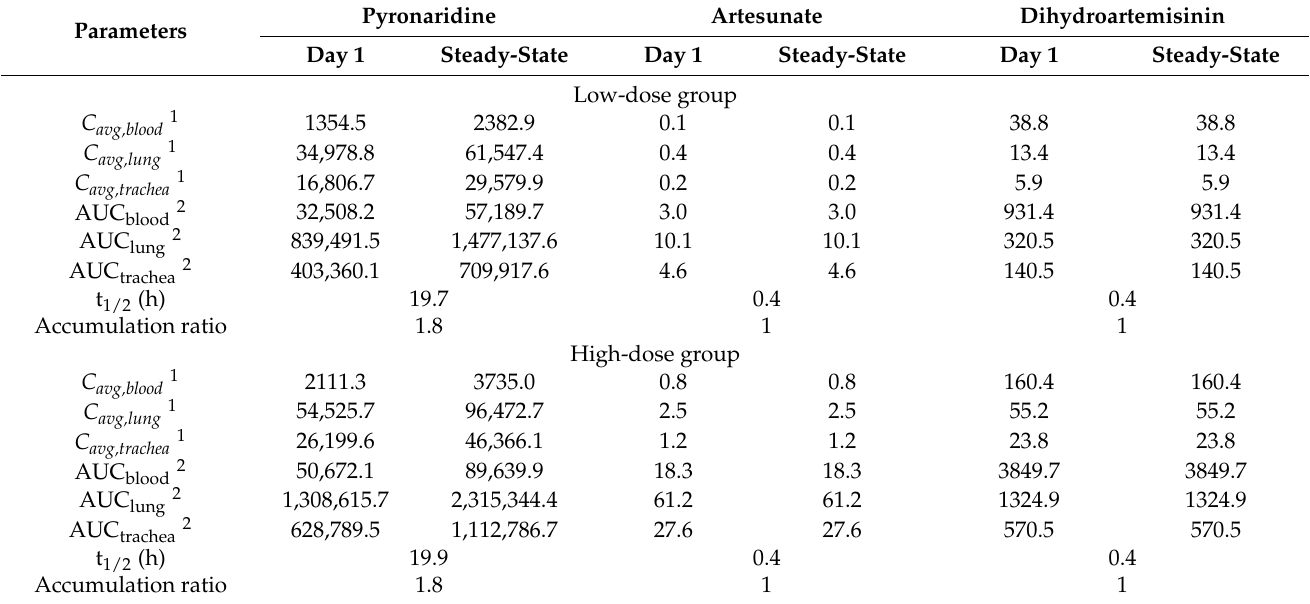
Table 3. Pharmacokinetic parameters of pyronaridine, artesunate, and dihydroartemisinin estimated from the simulated multiple-dosing PK profiles.